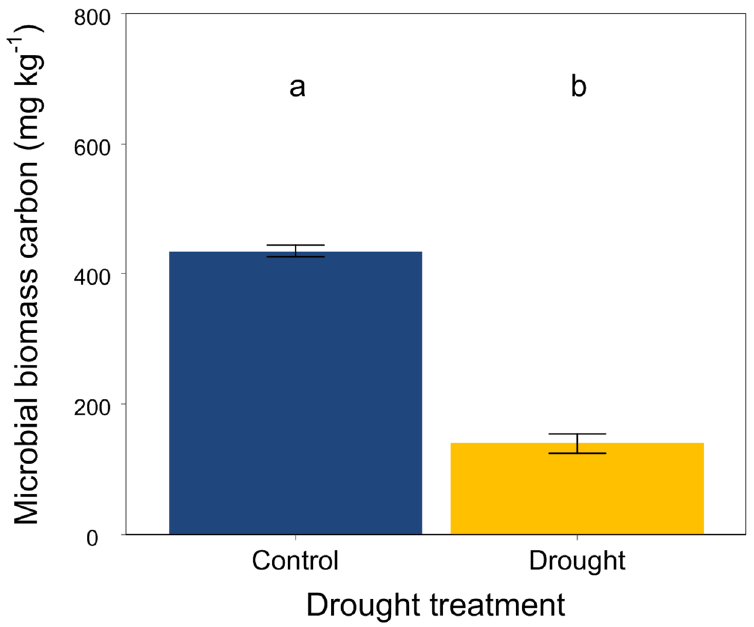
Figure 3. Effects of drought on ( A ) soil organic carbon, ( B ) total N, ( C ) total P, ( D ) the C:N ratio, ( E ) the C:P ratio, ( F ) the N:P ratio, ( G ) available P, and ( H , I ) inorganic N (NH 4+ -N and NO 3 − -N). Mean ± SE are shown (n = 12). Within each panel, different lowercase letters indicate significant differences at p < 0.05 (Tukey’s HSD).